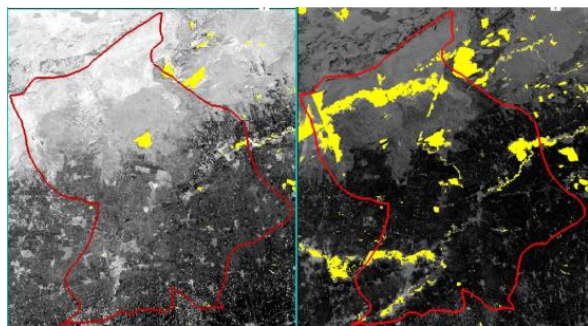
Figure 3. Extracted water bodies from NDWI image before (left) and after (right) flood, water bodies area appears as yellow